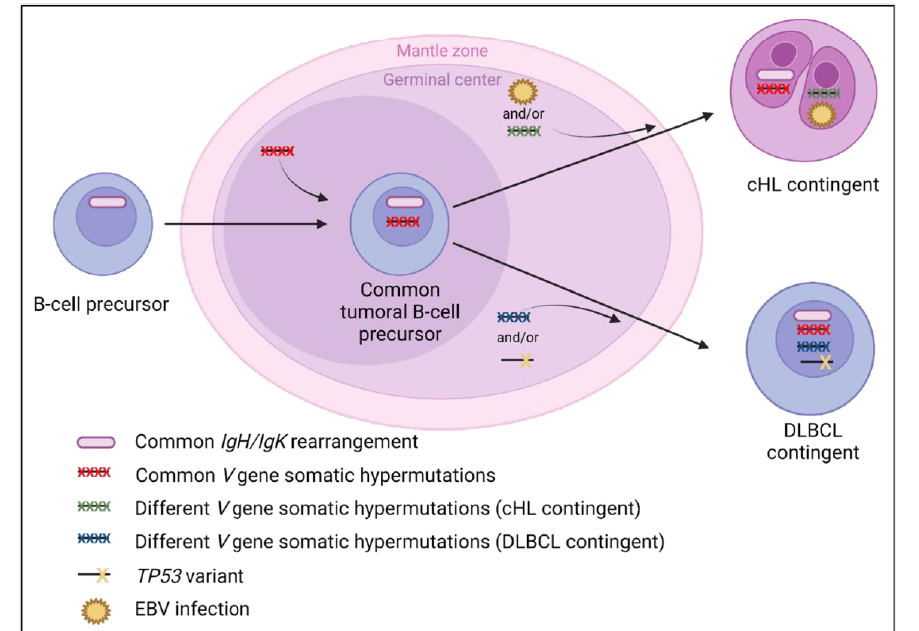
Figure 6. Suggested lymphomagenesis of classical Hodgkin lymphoma (cHL)/diffuse large B-cell lymphoma (DLBCL) composite lymphomas. Similar clonal IgH / IgK rearrangements between both